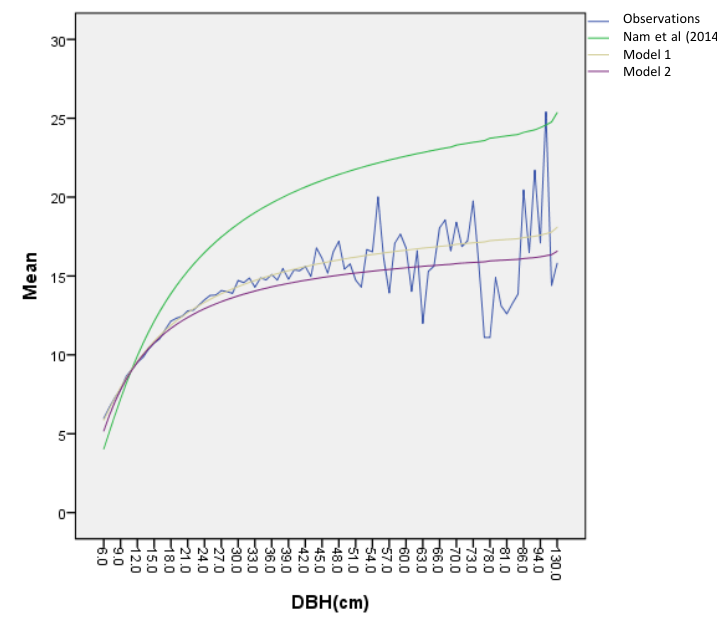
Figure D1. Predicted average tree height.